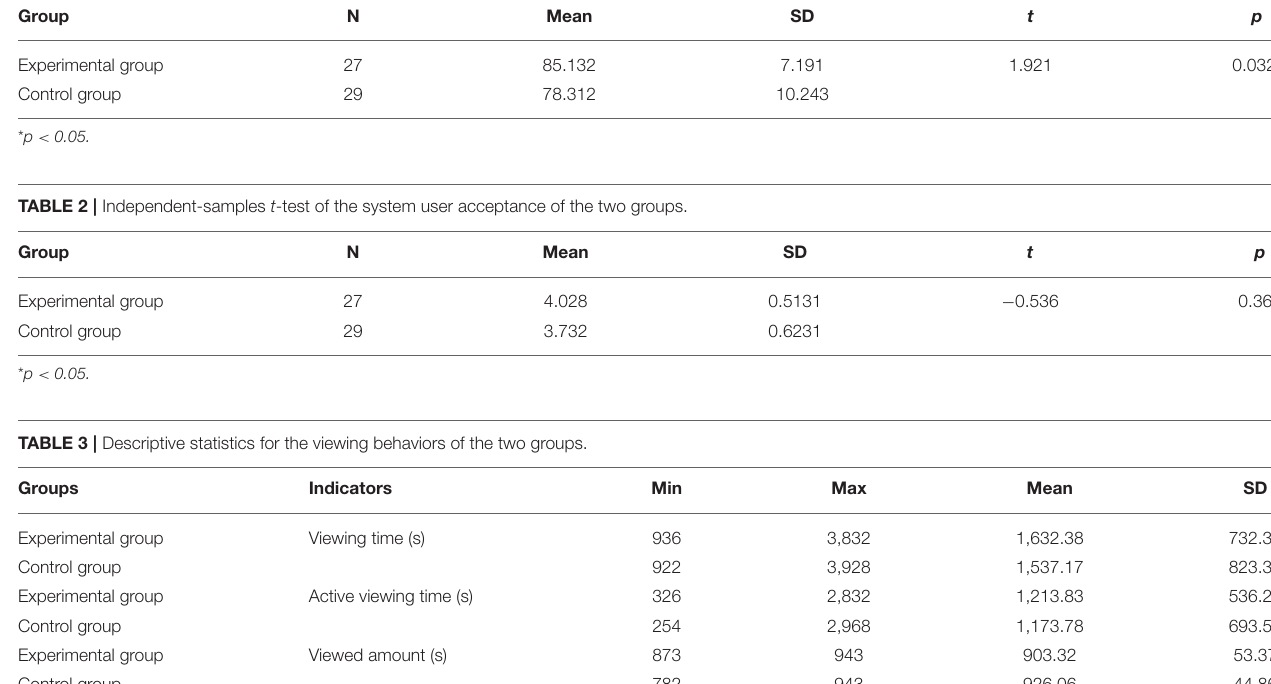
TABLE 1 | Independent-samples t -test of the learning achievements of the two groups. Group